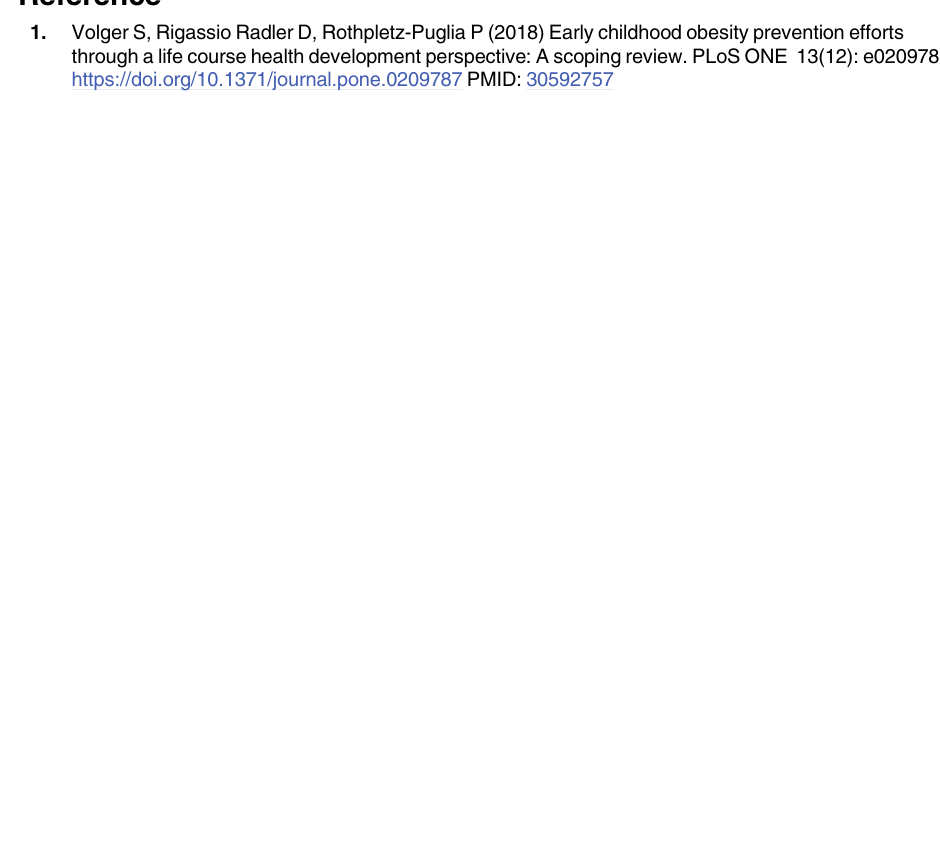
S1 File. Table 2. Characteristics of interventions during pregnancy. (PDF) S2 File. Table 3. Characteristics of interventions during infancy. (PDF) S3 File. Table 4. Characteristics of interventions during